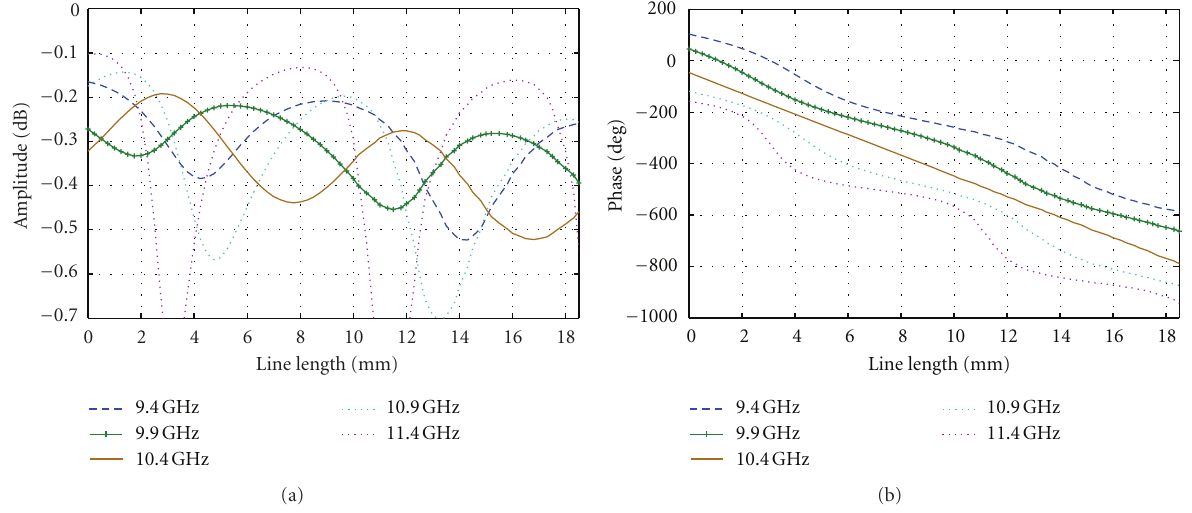
Figure 9: Reflection coe ffi cient in free space for the two-element subarray. (a) Amplitude. (b)